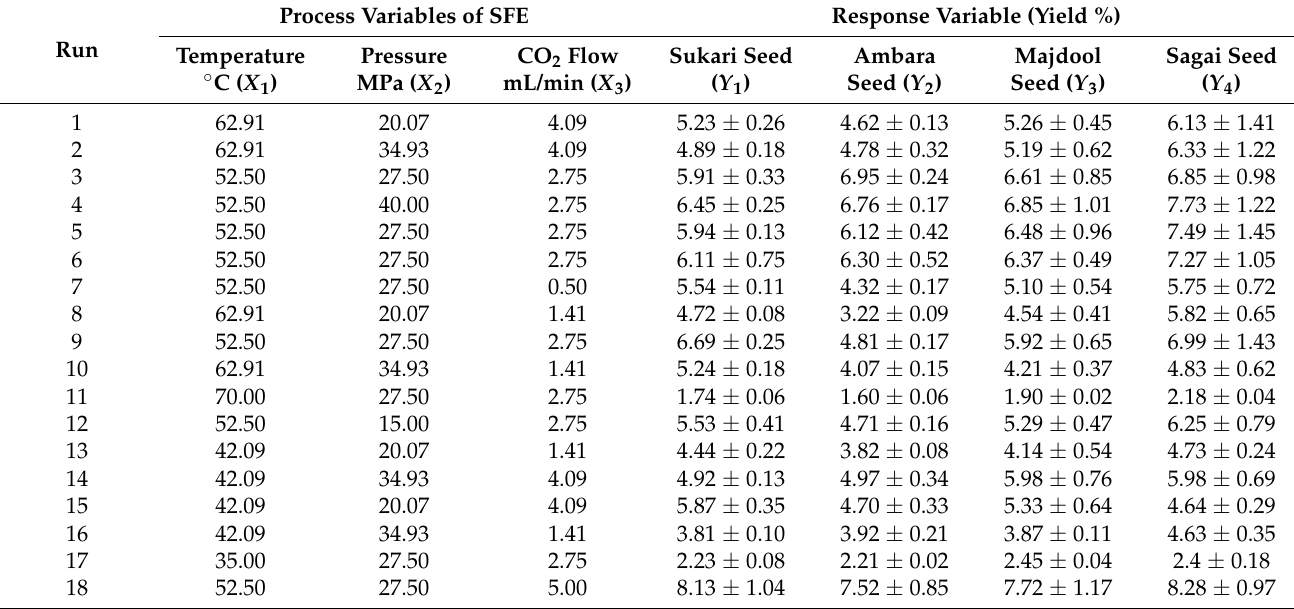
Table 1. Supercritical fluid extraction (SFE) yields from date seeds using designed